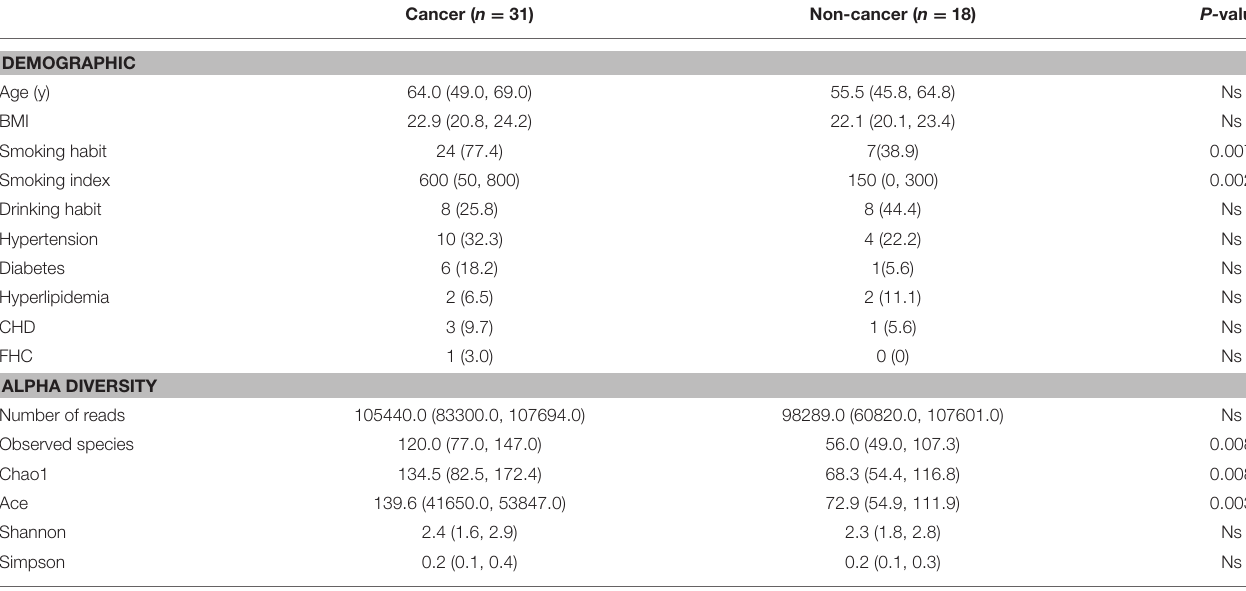
TABLE 1 | Comparisons of demographic characteristics and parameter of alpha diversity between cancer patients and non-cancer controls.